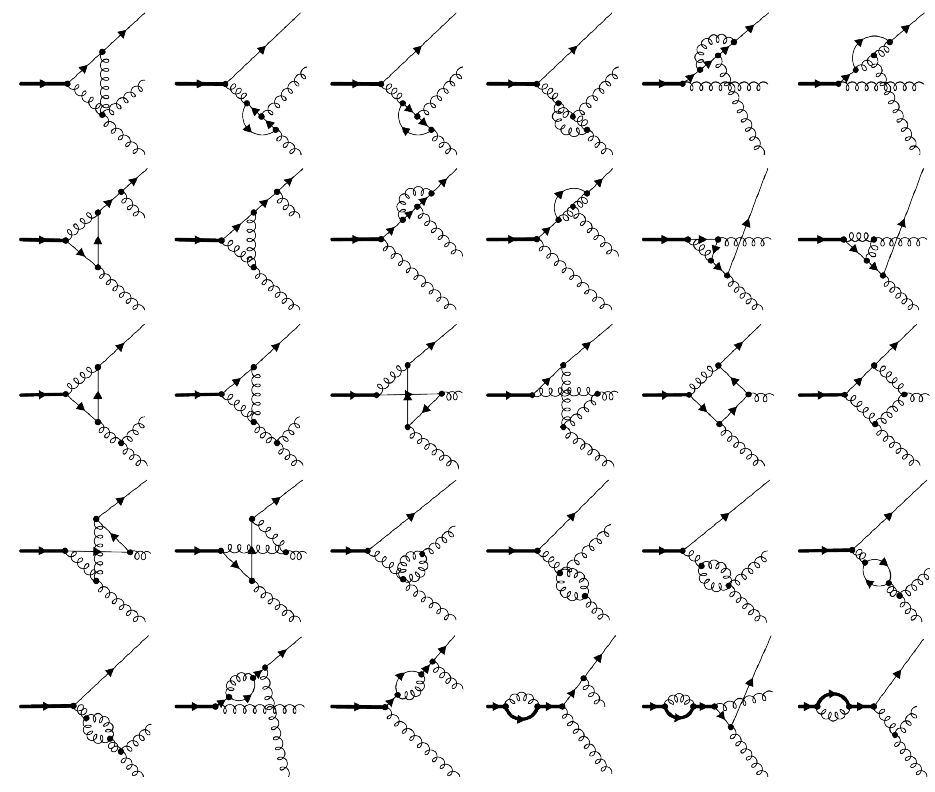
Figure 3 . 30 diagrams contributing to the splitting operator q → qgg Description as in figure